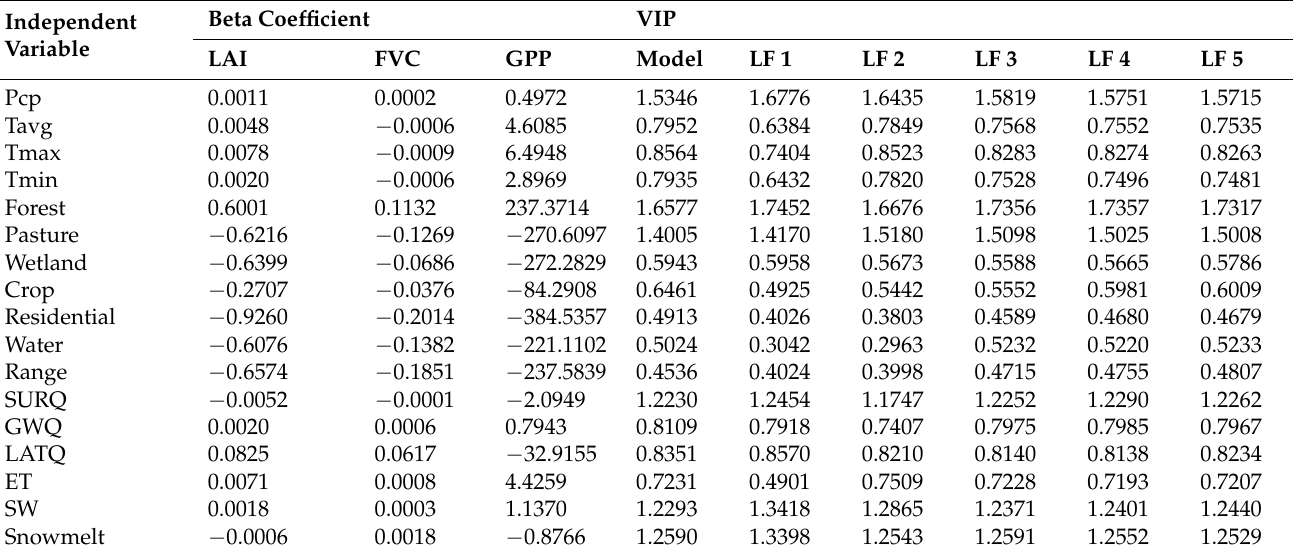
Table 5. Variable importance in the projection (VIP) values and beta coefficients of environmental factors in the PLSR model analysis.